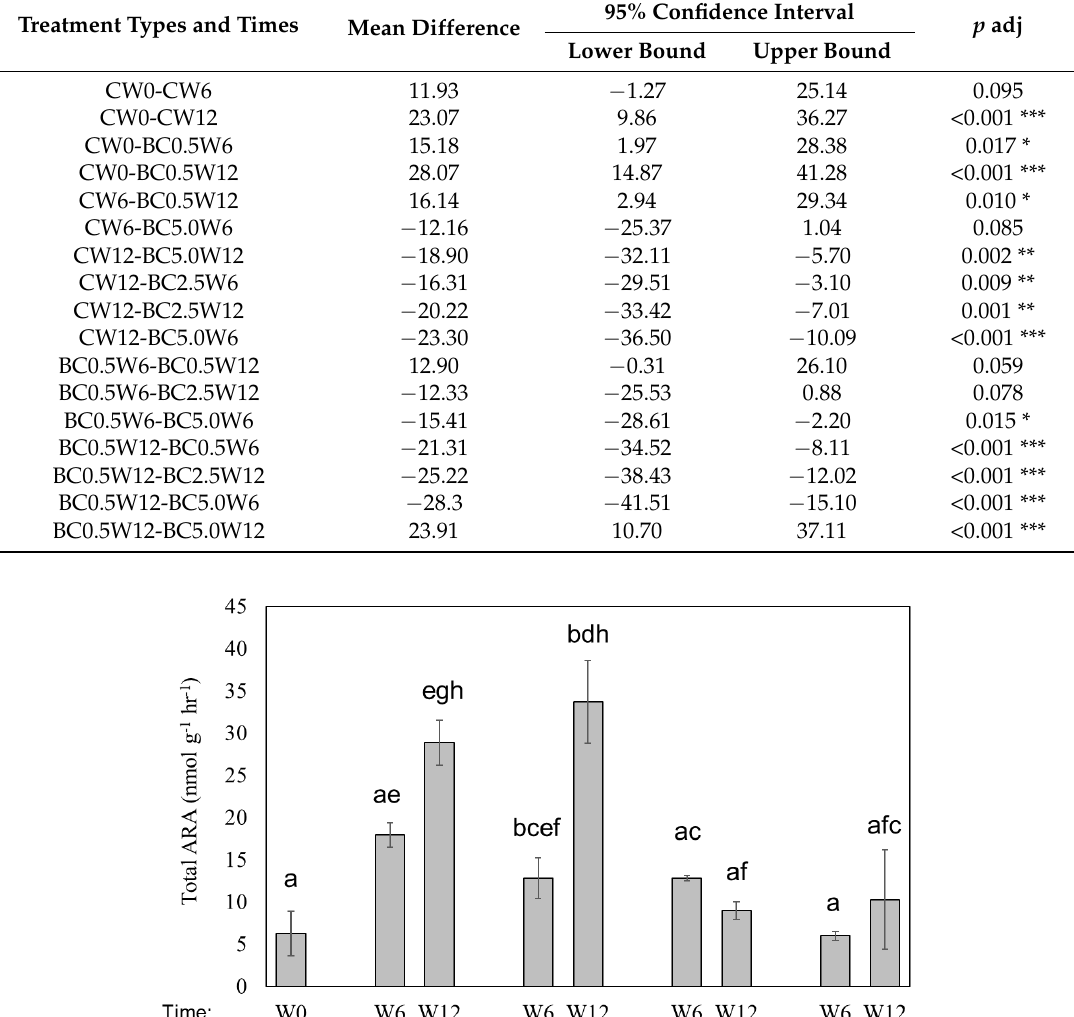
Table 1. Statistical data of potential biological N 2 fixation (BNF) rates between treatments and times. Single factor ANOVA (analysis of variance), where * represents p < 0.05, ** p < 0.01, and *** p < 0.001. All data not presented in the table had no significant differences ( p > 0.1), numbers after W represents the number of weeks the experiment was carried out at the time of sample collection.